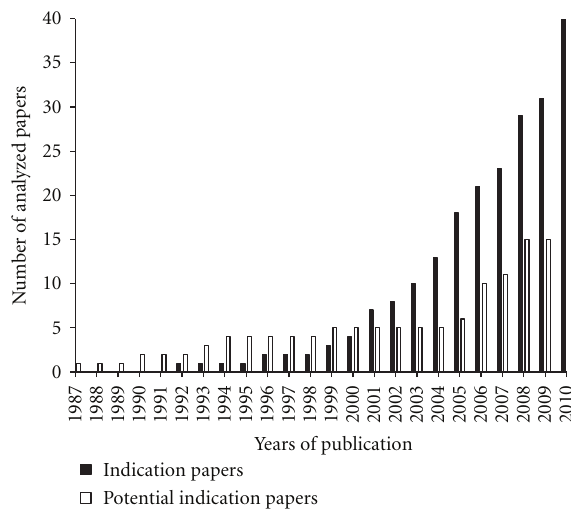
Figure 1: Trend of the number of analyzed papers regarding ants as indicators in Brazil. Indication papers — paper specifies (explicitly or implicitly) the intention of analyzing ants as indicators in the aim or introduction. Potential indication paper—the above criteria was not met, but the paper presents results that could potentially enable the use of ants as